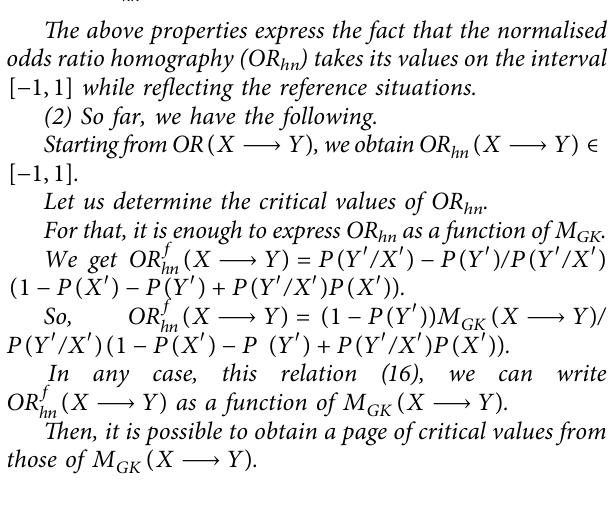
Table 2: The behaviour of the quality measures M reference situations.